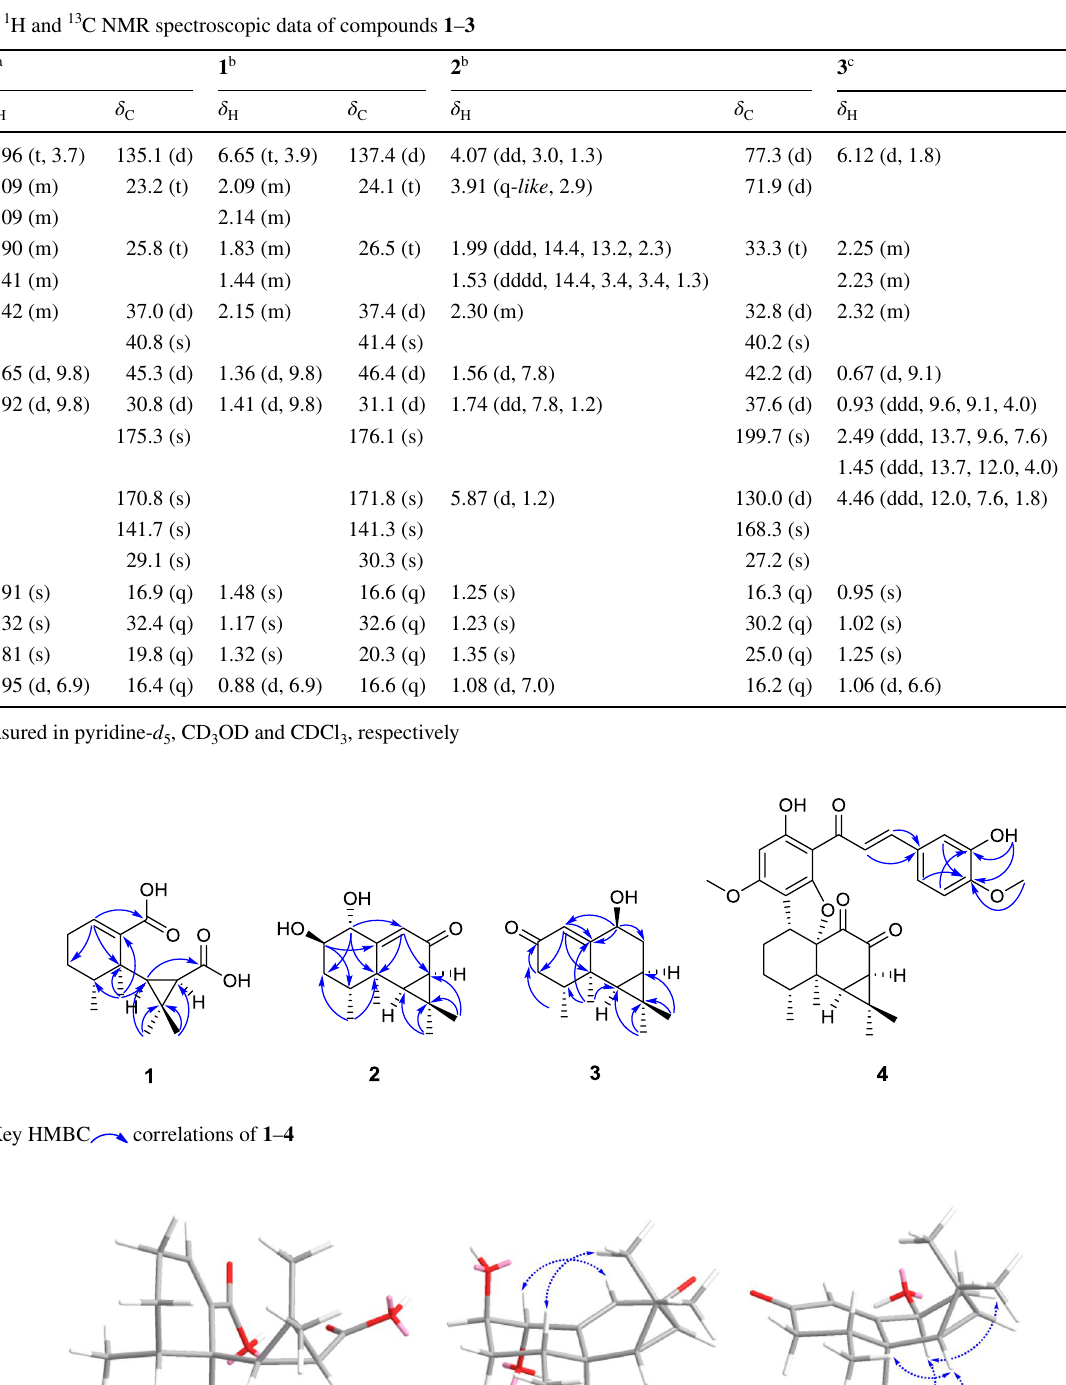
of 1 and aristolanhydride. For compound 1 , a positive-ion HRESIMS exhibited an [M + Na] + ion peak at m/z 289.1410,